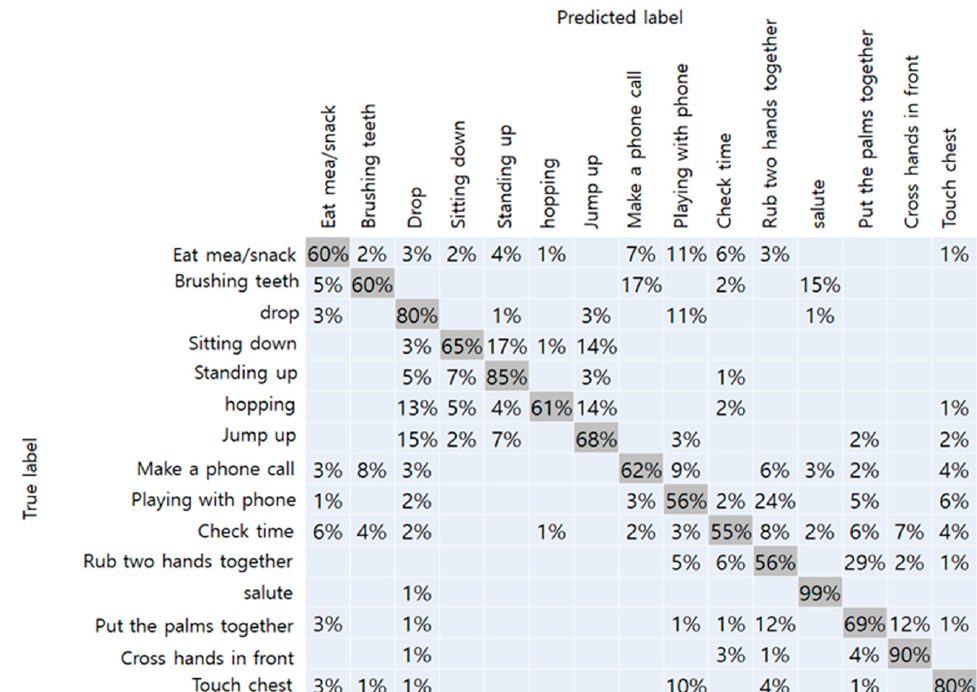
Figure 7. Confusion matrix of Kinect camera-17.